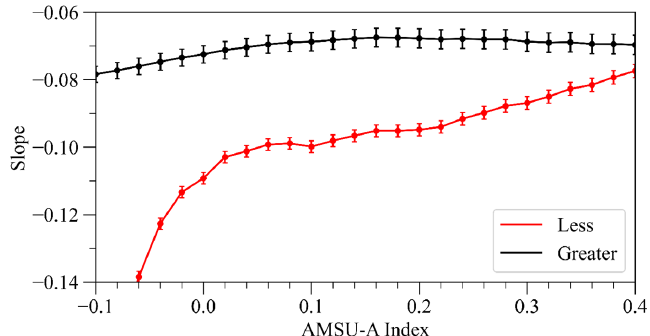
Figure 6. Fitted slope of the denominator and numerator with AMSU-A index values smaller than (red line) or greater than (black line) the threshold, along with the mean fitting errors shown with vertical lines. The AMSU-A cloud index was calculated using AMSU-A observations of NOAA from